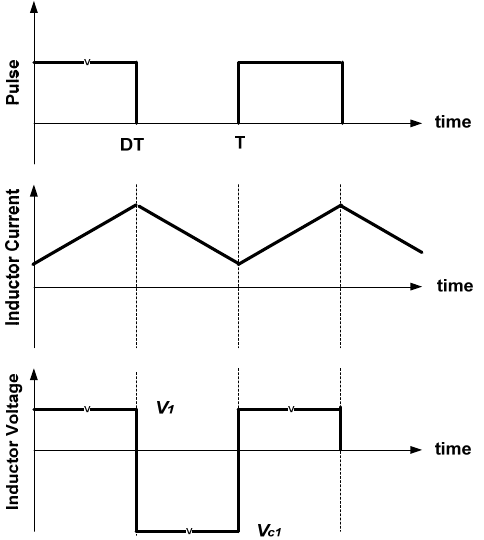
Figure 2. Modes of operation of the proposed converter: ( a ) switches are turned on; ( b ) switches are turned off; ( c ) discharge of stage capacitors through load.